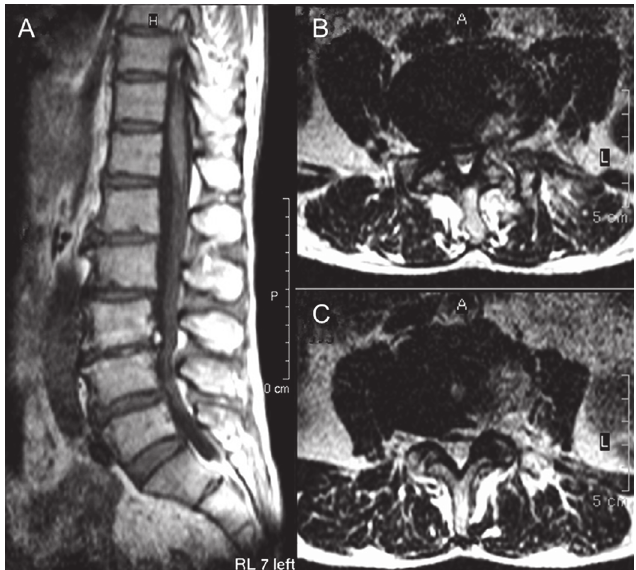
Figure 6: Both the T1 sagittal (A) and coronal MRI images of L3-4 (B) and L4-5 (C) at 1-month postoperatively, indicating that the herniation and stenosis at both levels were alleviated compared with the preoperative results, despite edema being observed.